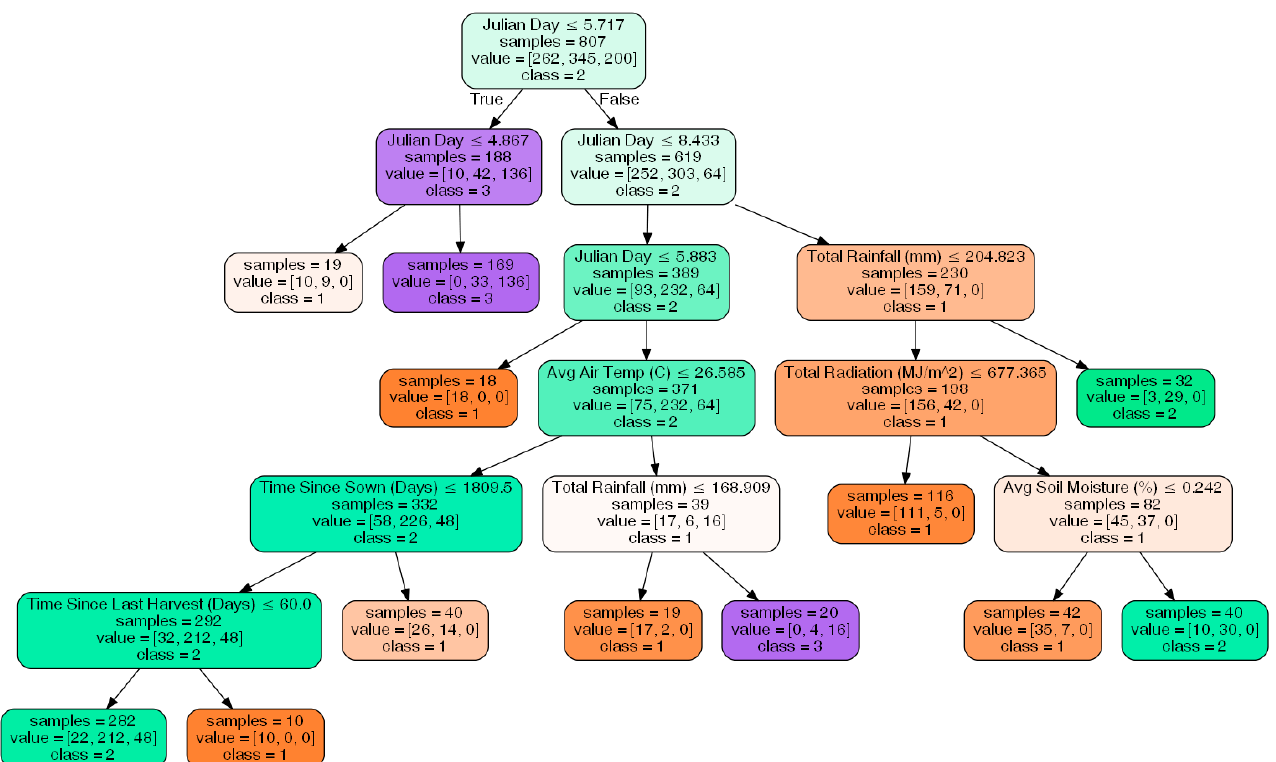
Figure 8. The classification decision tree that sorts data into bins.